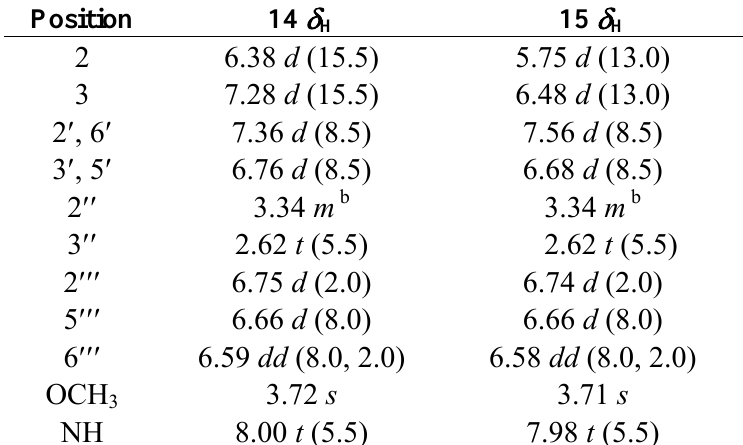
Table 2. NMR data for compounds 14 + 15 . a